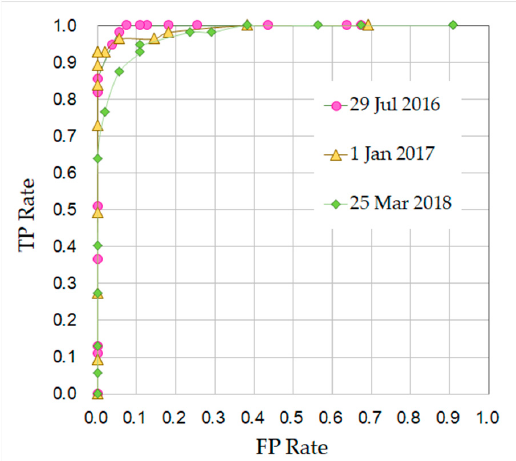
Figure 13. Receiver operating characteristics (ROC) curve for the true positive (TP) rate against the false positive (FP) rate based on the indicator and the training dataset with 110 labels in the Mashiki building map data.